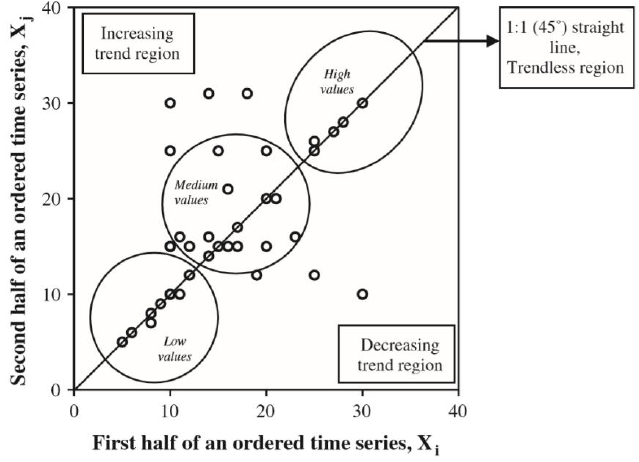
Figure 2. Illustration of decreasing, increasing and trendless regions [58].